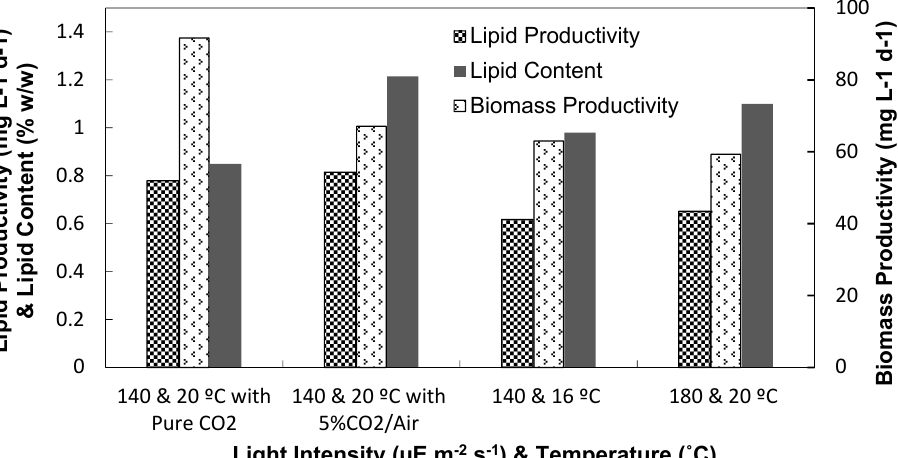
Figure 6. Biomass productivity, lipid contents, and lipid productivity of P. cruentum at different light intensities and temperatures as well as CO 2